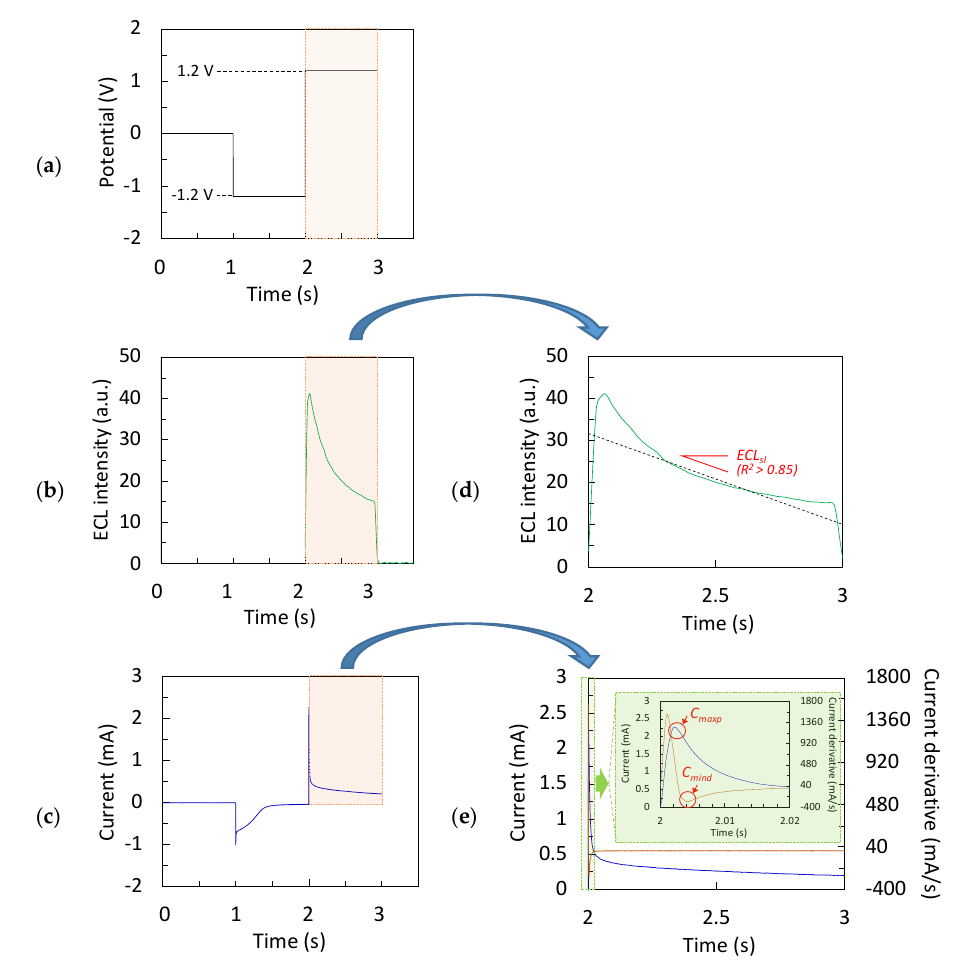
Figure 4. Chronoamperometry technique: ( a ) potential vs. time applied on carbon working electrode, ( b ) typical ECL response vs. time (green line), ( c ) typical current response vs. time (blue line), ( d ) zoom-in view of the shaded red box in Figure 4b, ( e ) zoom-in view of the shaded red box in Figure 4 c . Figure 4e also shows the current derivative signal (brown line) corresponding to the current response; the green box magnifies these responses. C maxp : maximum value of the current peak, C mind : minimum derivative value of the current, ECL sl : decay slope of the ECL intensity.